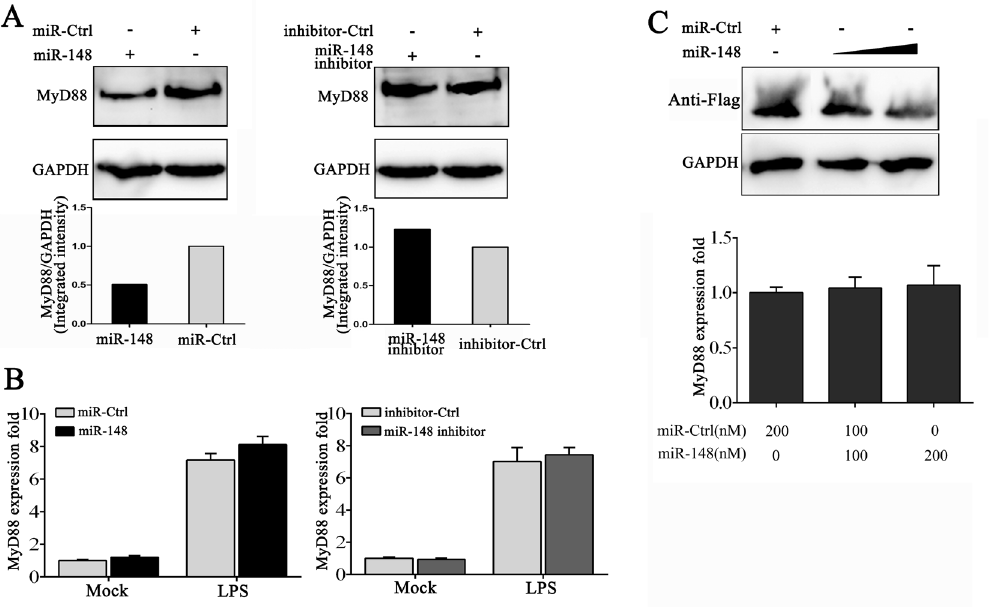
Figure 4. miR-148 inhibits the expression of MyD88. ( A ) The miiuy croaker macrophages were transfected with miR-148 or miR-Ctrl and miR-148 inhibitor or Ctrl-inhibitor for 24 h, which then stimulated with LPS for another 24 h. After 48 h transfection, the protein levels of MyD88 were determined by Western blot. Mock group represents the macrophages without stimulation. Cropped blots are shown for antibodies For un-cropped blots, see Supplemental Figure 2. ( B ) The mRNA levels of MyD88 were also determined by qRT-PCR at 48 h post- transfection. ( C ) HEK293 cells were transfected with MyD88 expression plasmid containing Flag tag, together with miR-148 or miR-Ctrl with concentrate gradient. After 48 h, the anti-Flag Western blot was conducted to detect the protein levels of MyD88. A cropped Flag blot is shown. For un-cropped blots, see Supplemental Figure 2. The mRNA levels of MyD88 were also determined after 48 h transfection. The mRNA expression profiles was normalized to the expression of β -actin and represented as fold induction relative to the expression level in control cells that was set to 1. Data was presented as the means ± SE from three independent triplicated